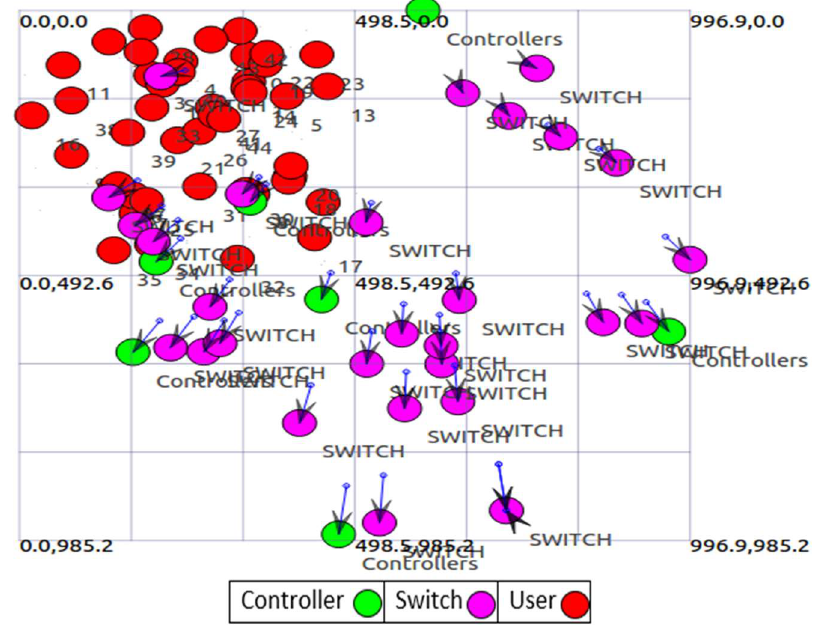
Figure 4. Multi-controller placement optimization by the SA-MCSDN algorithm.